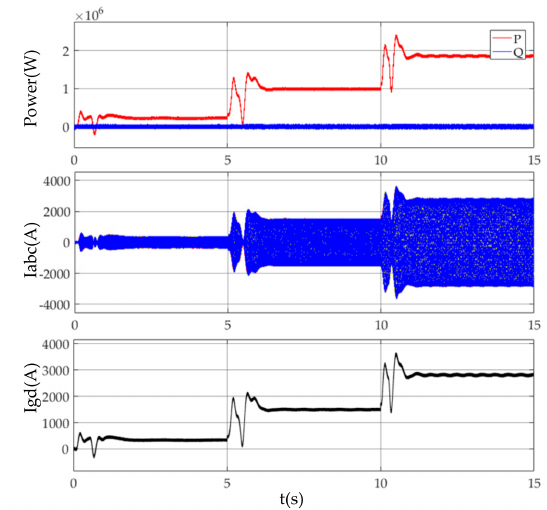
Figure 12. The waveform of grid connection point power and current after suppression.